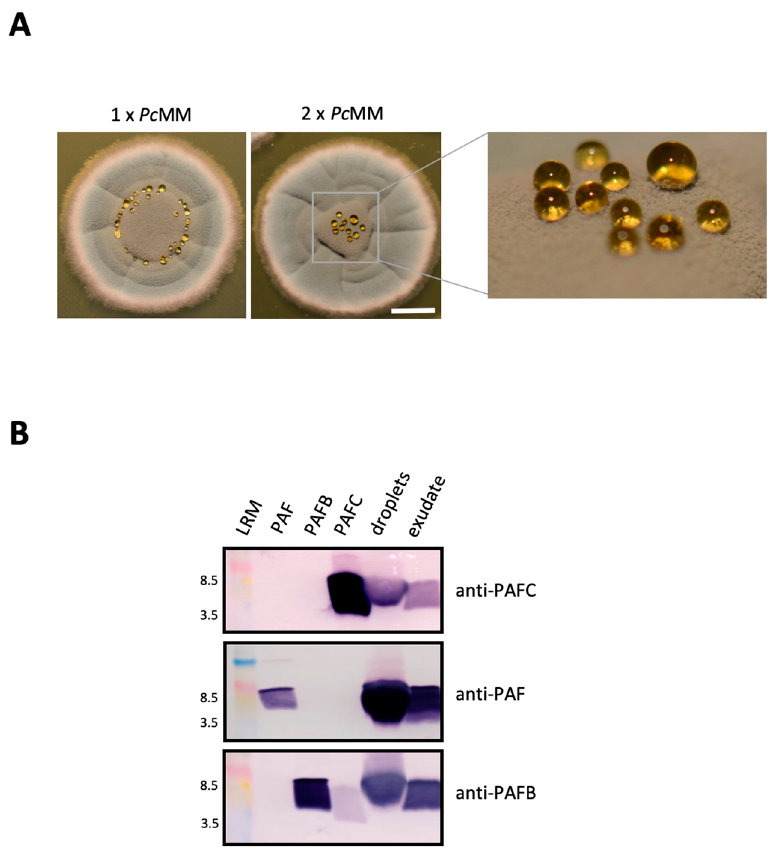
Figure 3. Detection of PAFC in P. chrysogenum exudate. ( A ) Droplet formation on P. chrysogenum surface cultures grown on 1 × Pc MM and 2 × Pc MM for 120 h at 25 °C. Scale bar, 5 mm. ( B ) For Western blot analysis, 20 µ L of droplets and exudate from cultures grown on 2 × Pc MM were loaded per lane, fractionated on an 18% ( w / v ) SDS-polyacrylamide gel and transferred onto a nitrocellulose membrane. Polyclonal antibodies were used to detect PAFC, PAF and PAFB. As a control for antibody binding, 0.5 µ g of the respective recombinant protein (PAFC, PAF and PAFB) was loaded per lane. LRM, low range rainbow marker (GE Healthcare Life Sciences, Little Chalfont, UK). The molecular weight marker bands of 3.5 kDa and 8.5 kDa are indicated.